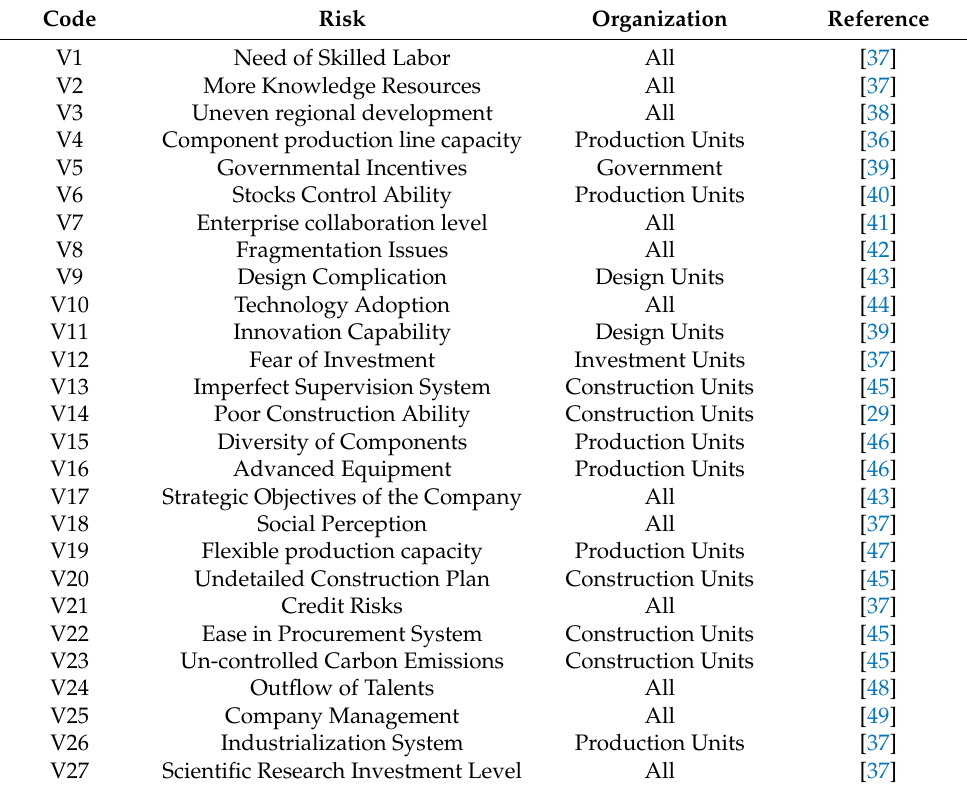
Table 1. Risks of industrialized construction based on literature